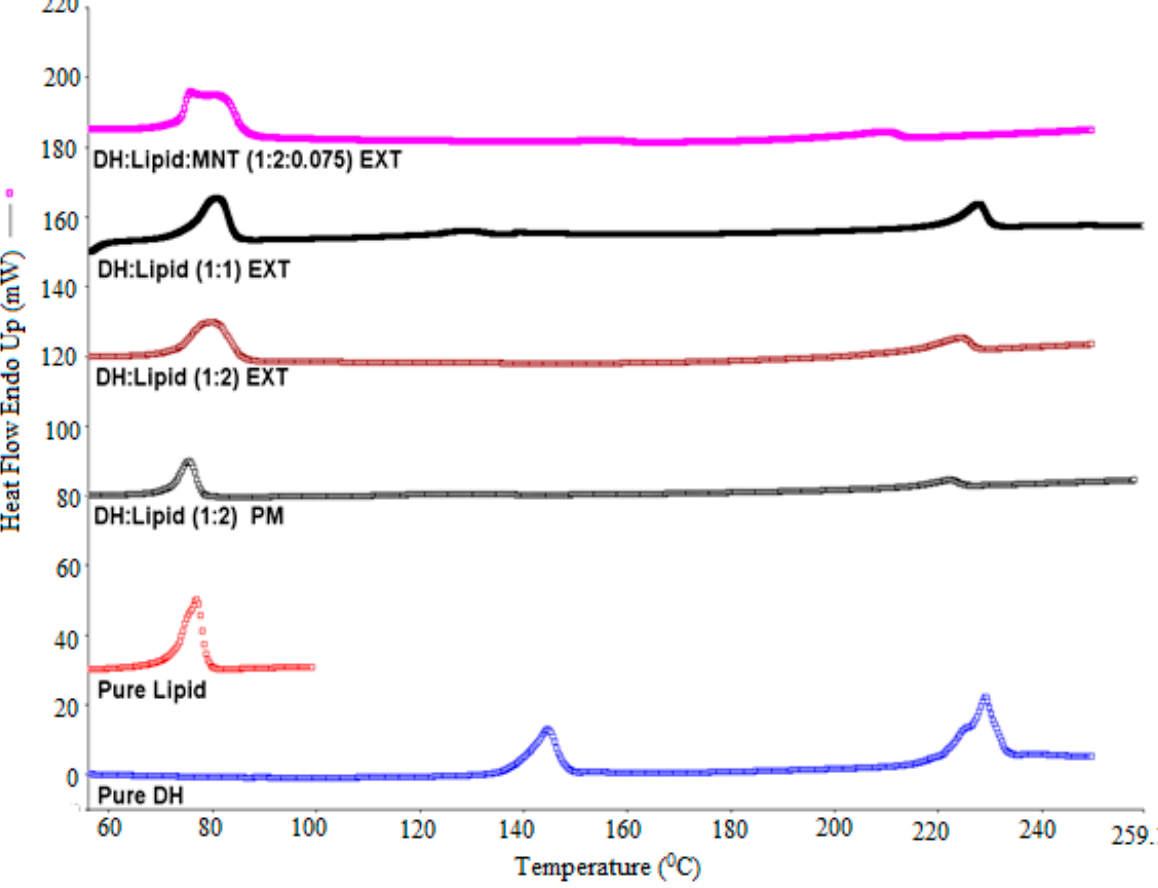
Figure 2. DH/C-888 and DH/C-888/MNT DSC studies performed at temperatures of 30–250 °C and a heating rate of 20 °C/min.